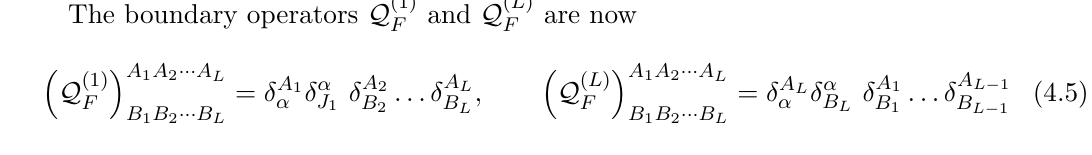
the insertion by the (cid:12)elds W B 1 W B 2 (cid:1) (cid:1) (cid:1) W B m . Thus, (4.4) is a term that changes the length of the spin chain, since it converts three bosons into two fermions and vice